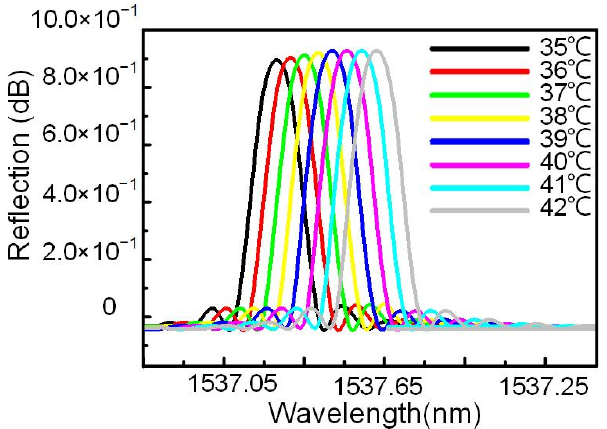
Figure 2. Reflection spectra of two-sided WBG at different temperatures.